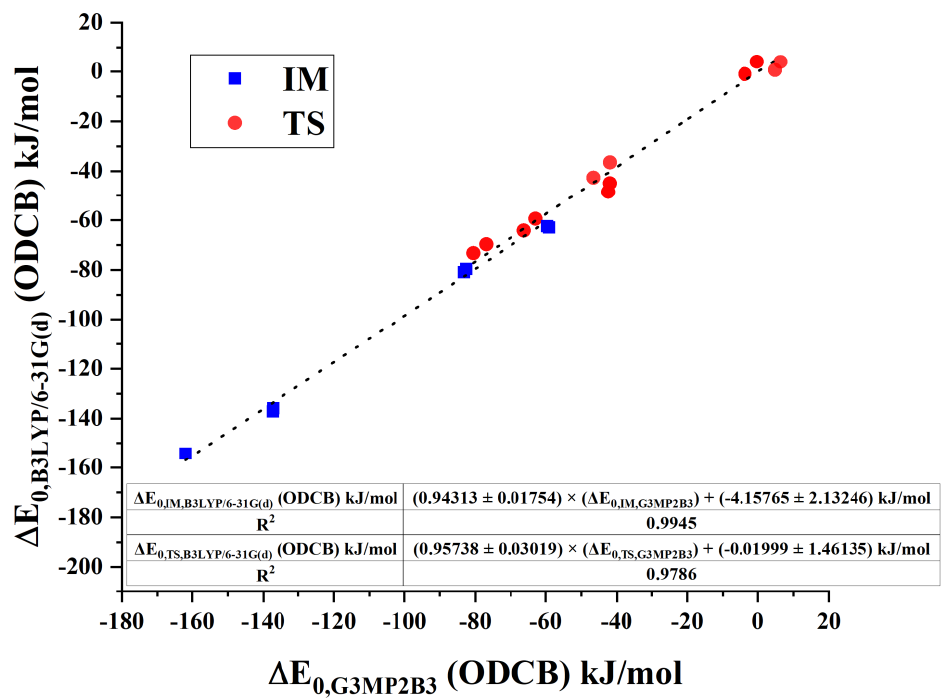
Figure 9. Comparison of intermediate and transition-state energies in ODCB obtained by B3LYP/6- 31G(d) level of theory and G3MP2B3. Fitted plots are marked in dotted lines.